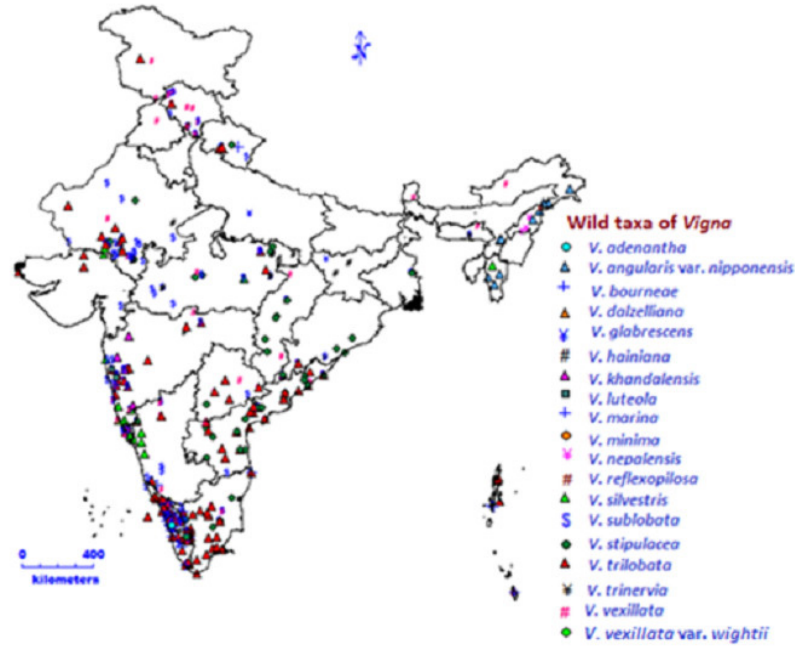
Figure 1. Georeferenced and diversity richness map of wild Vigna germplasm.